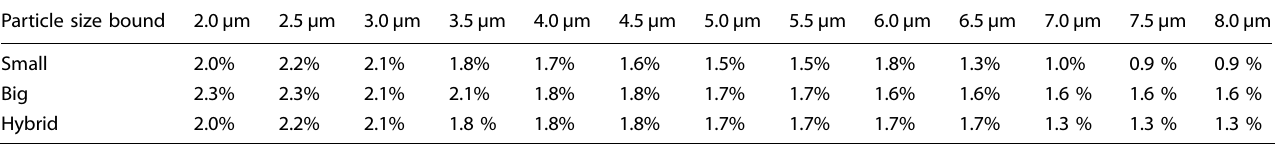
Table 2. Standard deviation (%) for each bounding method for various particle